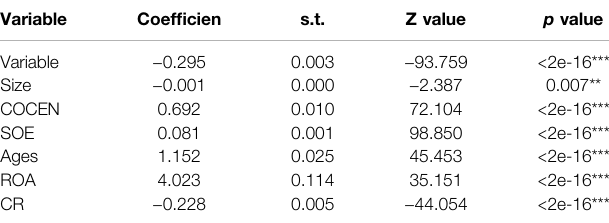
TABLE 3 | PSM logit regression results about excitation.